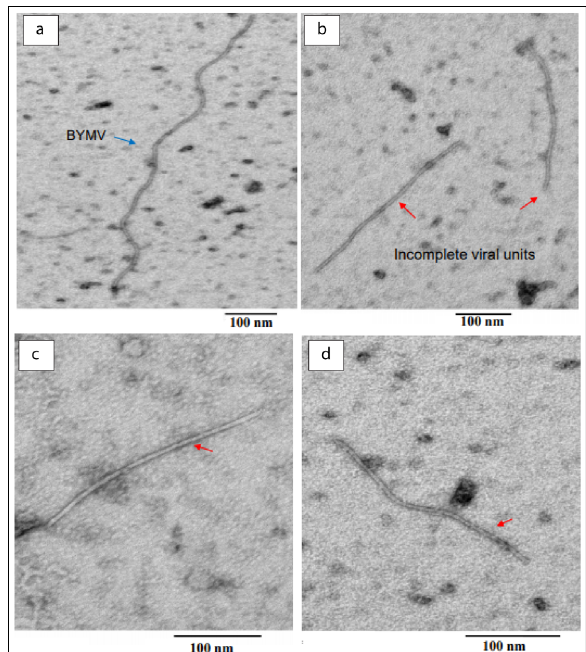
Figure 5: Transmission electron micrograph of Bean yellow mosaic virus (BYMV) particle unit obtained from chitosan nanoparticle (ChiNP)-treated plants (b, c, d) and untreated control (a). Red arrows indicate the defective viral particles in ChiNP-treated plants. Photos were captured under direct magnification of 100 000 x with scale of 100 nm, HV=80.0